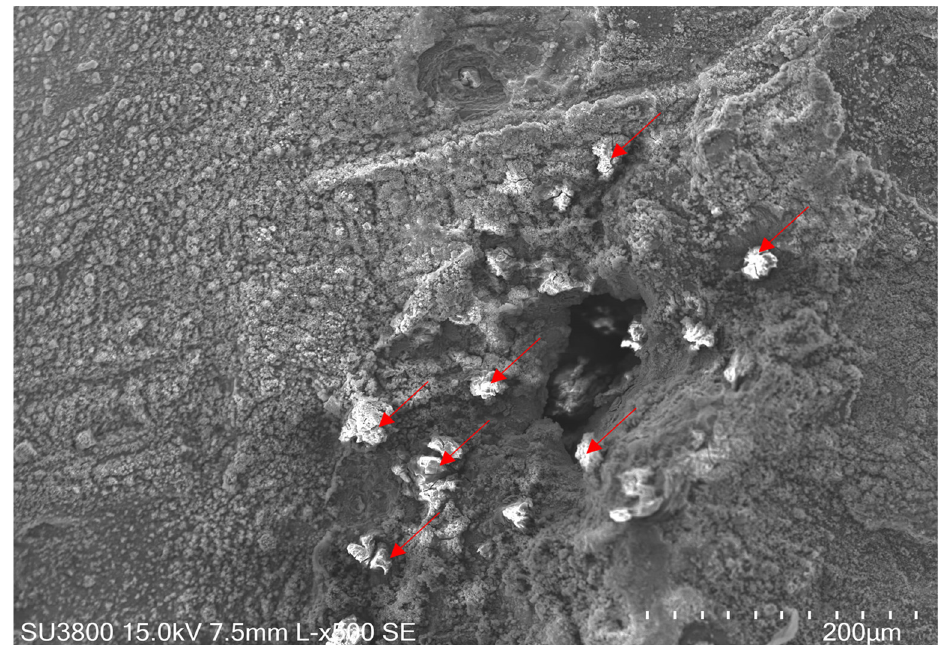
Figure 10. Fracture surface observed by SEM, β = 90° under saline corrosion.